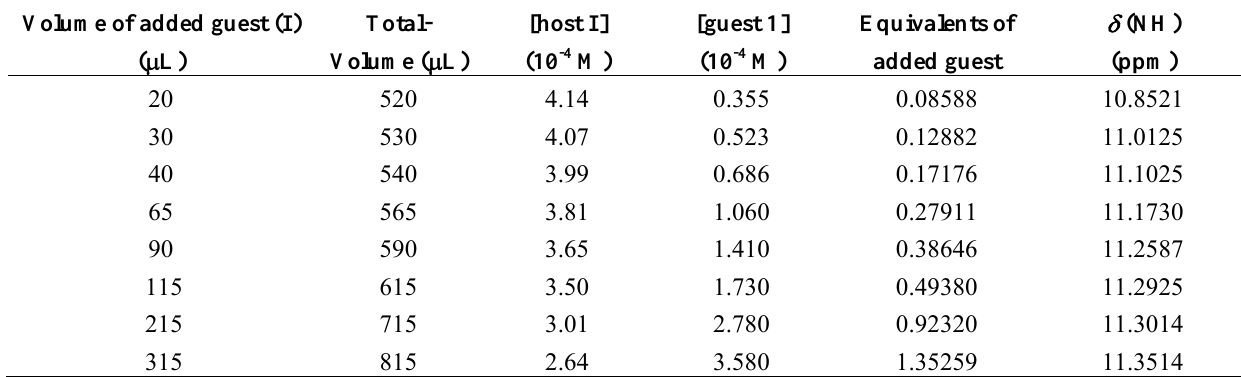
Table 4. Representative table for a non Saturation Titration conditions (n ST ) of host I